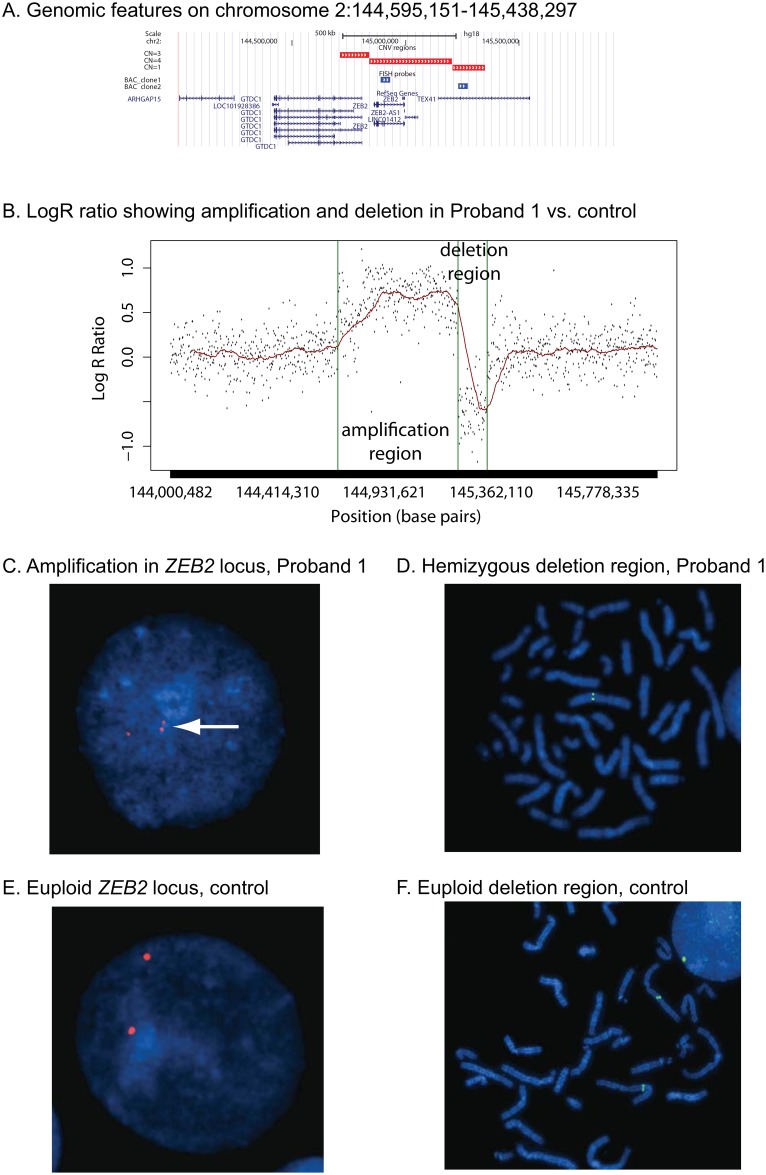
Evidence of a tandem amplification and heterozygous deletion at the ZEB2 locus in proband 1.(A) Genomic landscape (from the UCSC Genome Browser, GRCh36/hg18, a ~2 Mb region spanning chr2:144000482–145945938 corresponding to all SNPs on the Affymetrix array from 144–146 Mb). (B) LogR ratio plot of amplification/deletion region for proband 1 and control (from the GRCh36/hg18, chr2:144000482–145945938). Vertical bars indicate the beginning and end of the amplification and deletion regions. Red line indicates a moving average. (C) Representative example of interphase FISH with labeled fosmid G248P8731F5 using lymphoblast cell lines derived from proband 1 and (E) an unaffected control. Note the presence of three copies in the patient (panel C, white arrow indicating a duplication homolog). (D) Representative example of metaphase FISH using a probe from the deletion region (fosmid G248P85468F6). (F) Metaphase FISH in a euploid control reveals the expected two chromosomal copies of this fosmid probe.